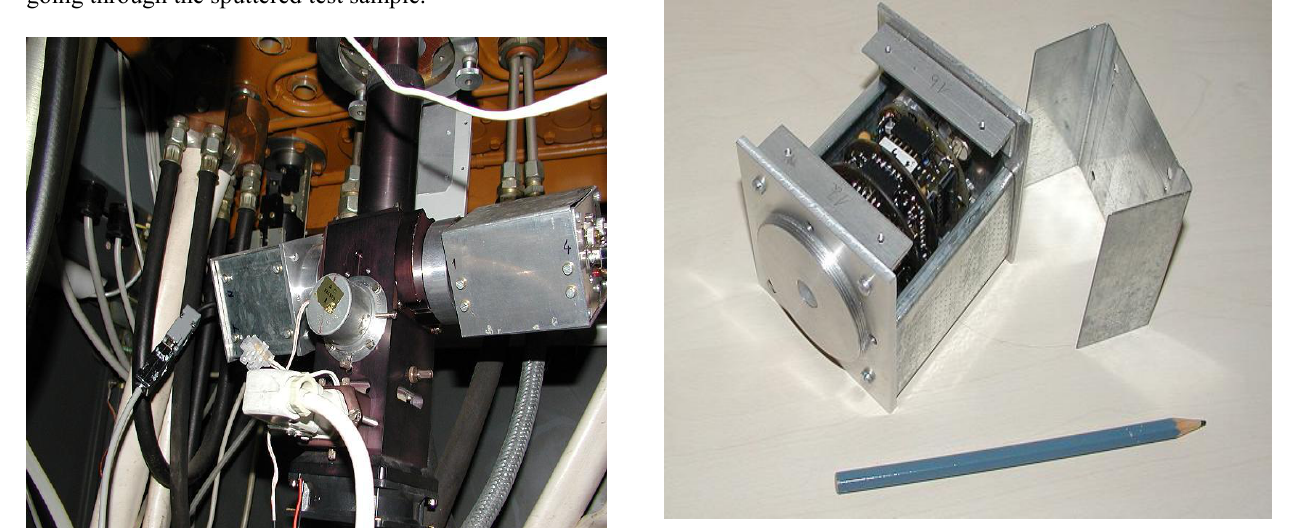
Fig. 3. Photonometer in the coating machine B63D with prototypes of photosensors